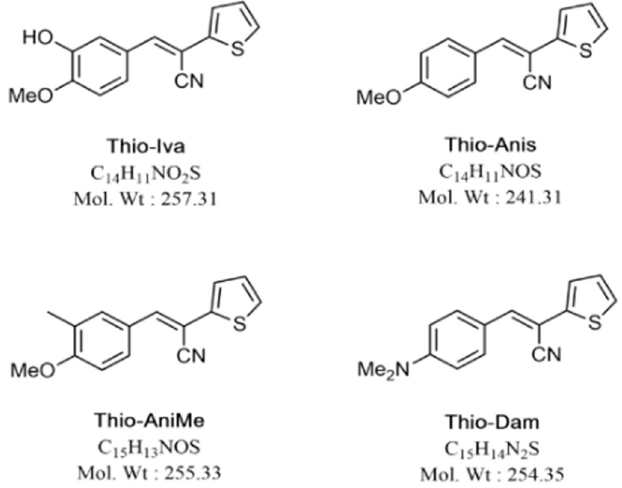
Figure 1. Chemical structures of E-2-(2-thienyl)-3-acrylonitrile RTK inhibitors used in this study.